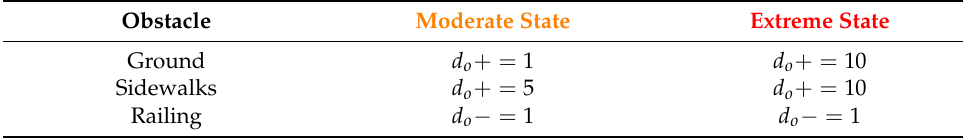
Table 2. Difficulty of the different obstacles in the